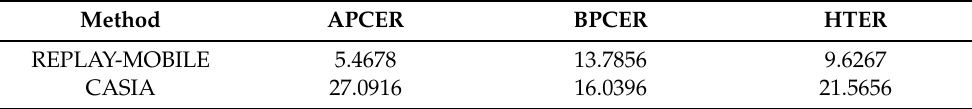
Table 4. Results (%) on considered face recognition